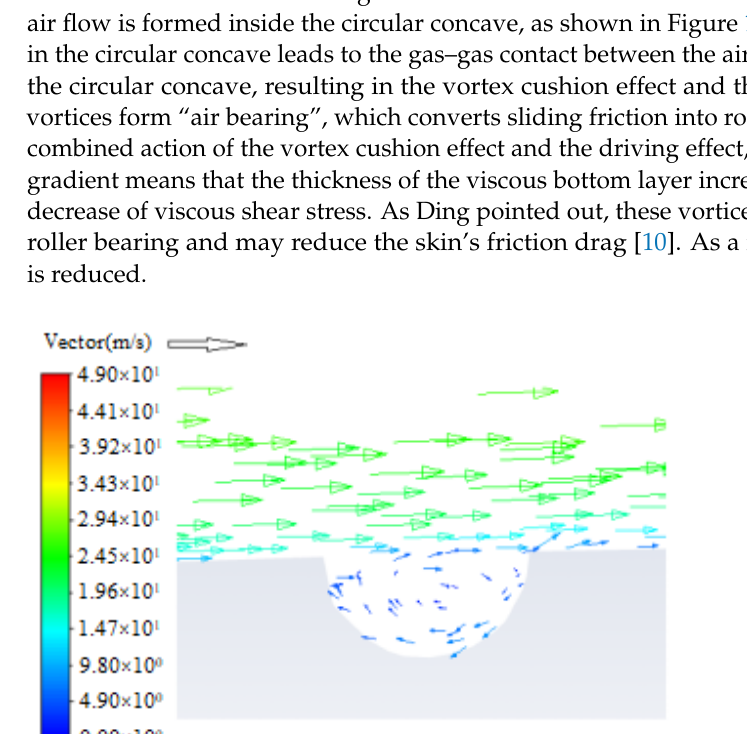
( b ) Figure 11. ( a ) The roof of the original minivan without circular concaves. ( b ) The roof of the opti- mized minivan with circular concaves.